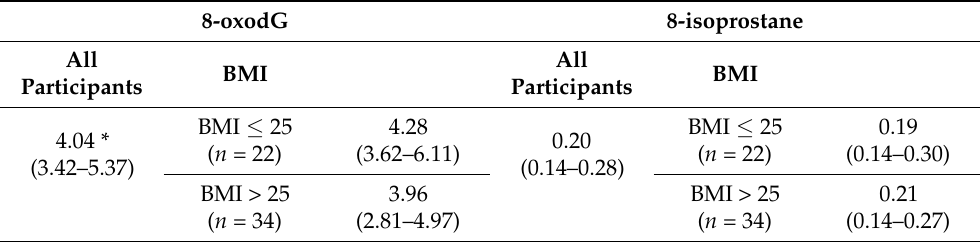
Table 4. 8-oxodG and 8-isoprostane concentrations in participants’ urine. 8-oxodG